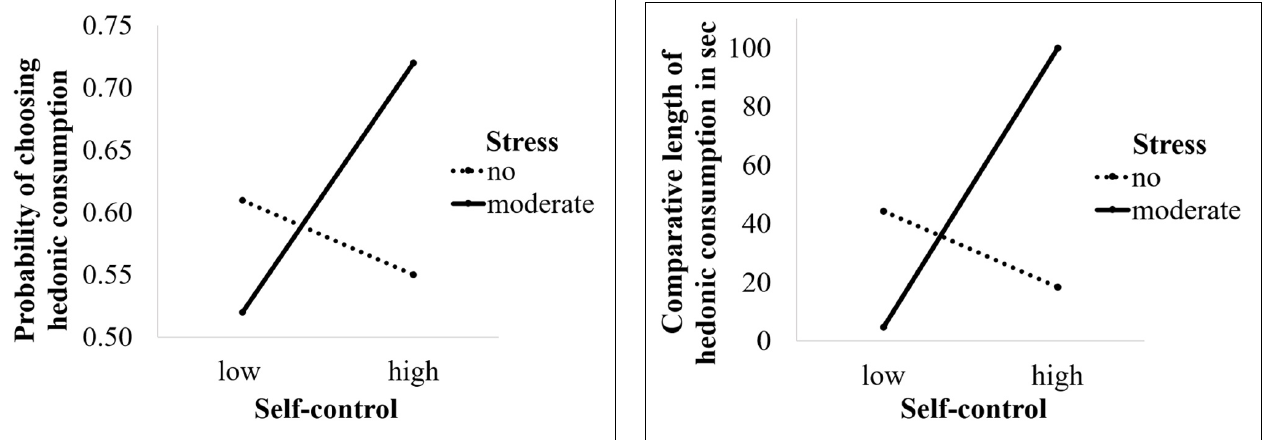
FIGURE 2 | Effects of stress and self-control on the probability of choosing hedonic over neutral consumption.